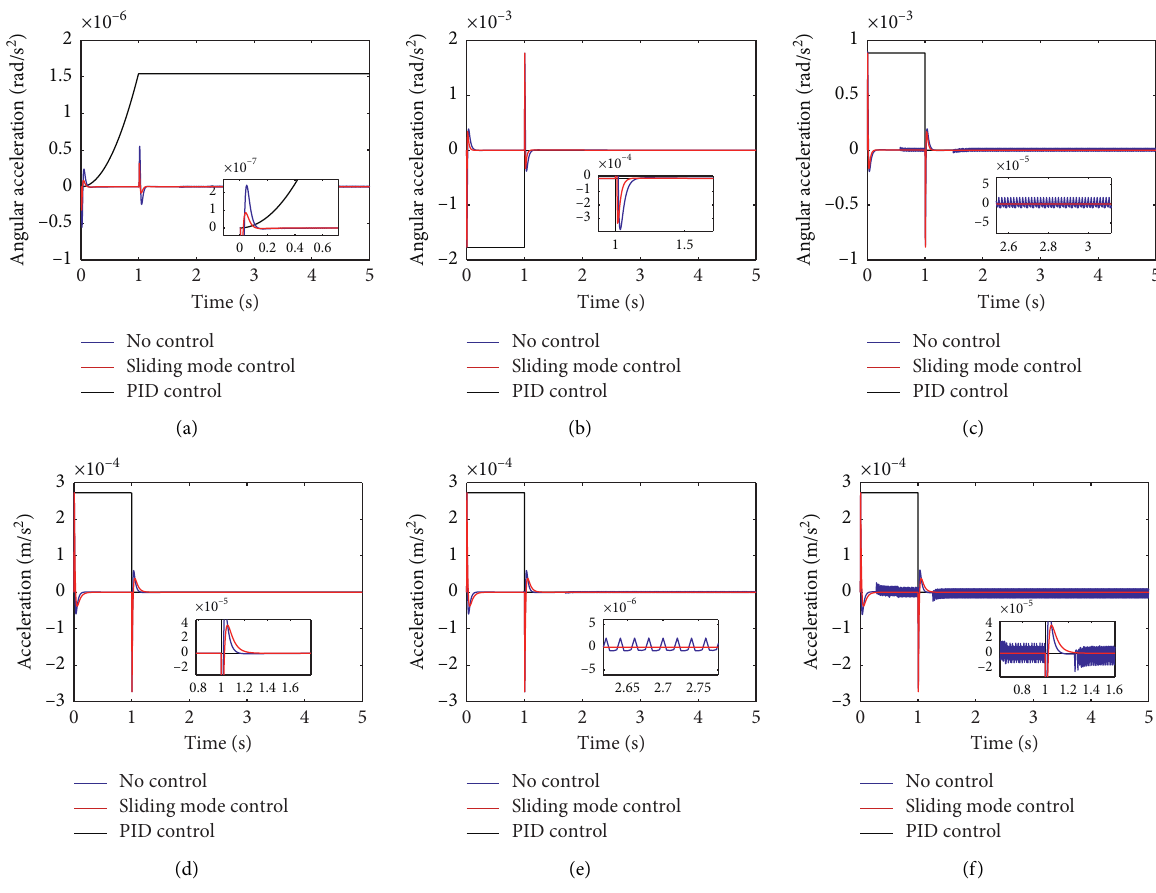
€ θ € θ € x , (e) € y , and (f) € z x , (b) y , (c) z , (d)